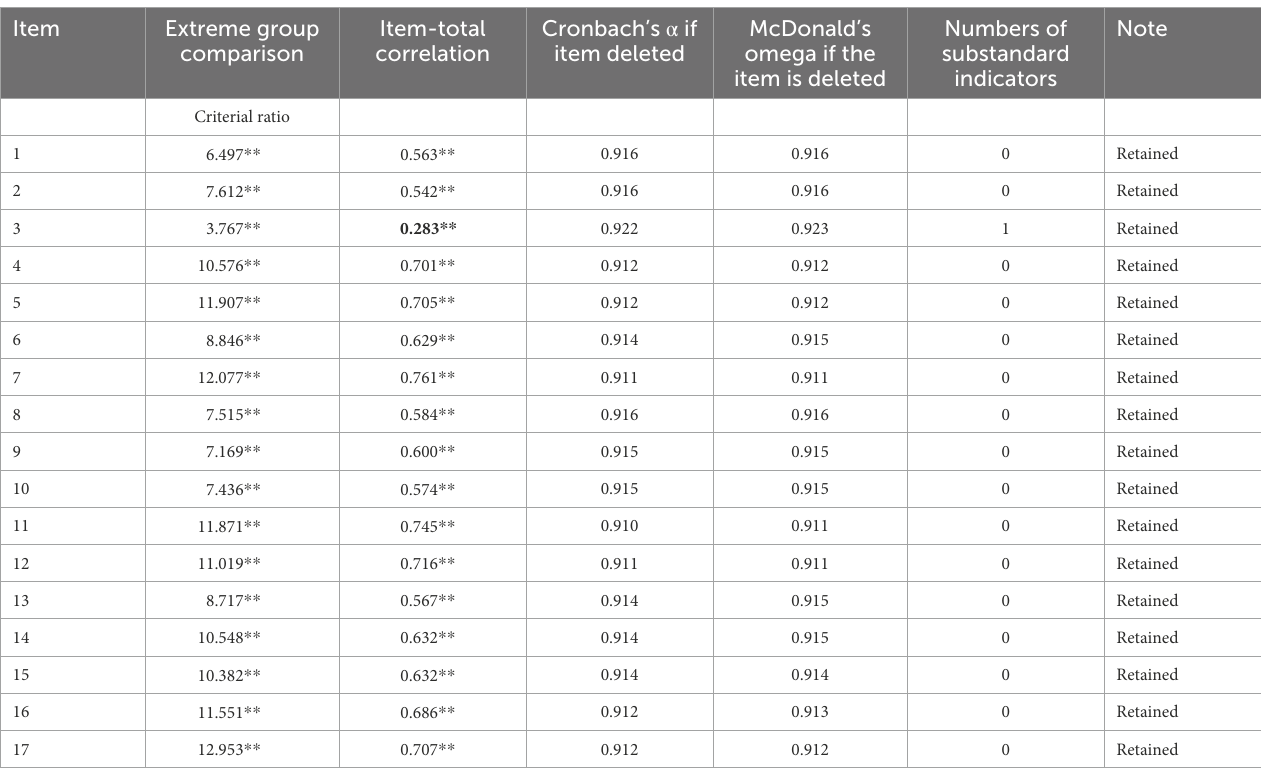
TABLE 2 Item analysis ( N = 170).